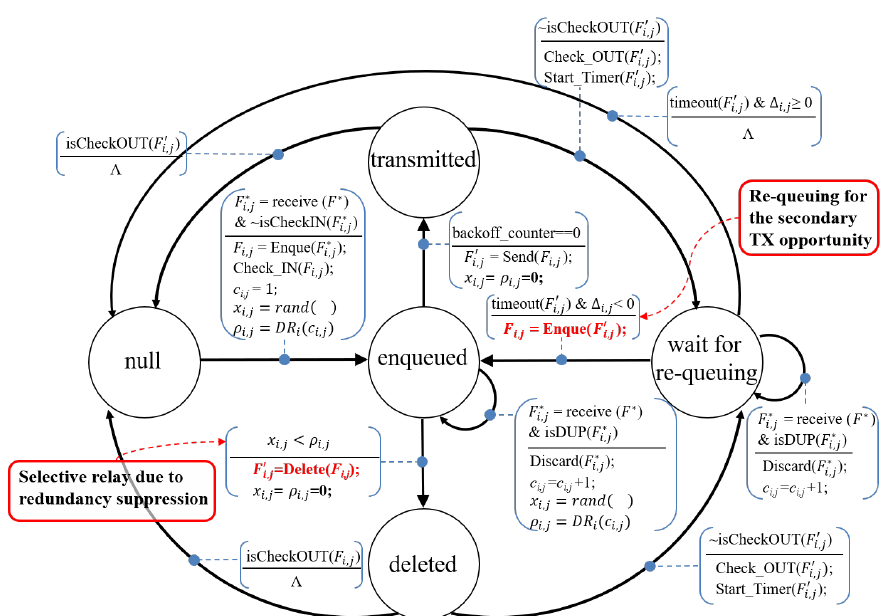
Figure 8. A state diagram of the proposed mechanism consisting of the duplication suppression and re-queuing